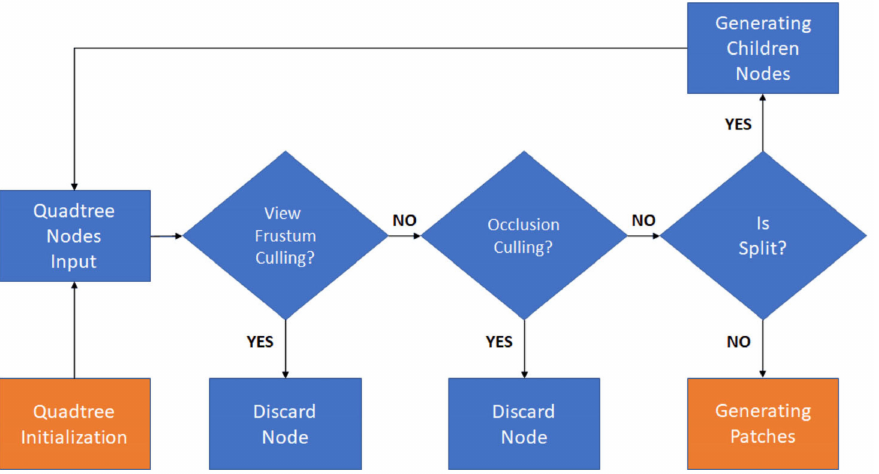
Figure 9. Flowchart of quadtree initialization and patches